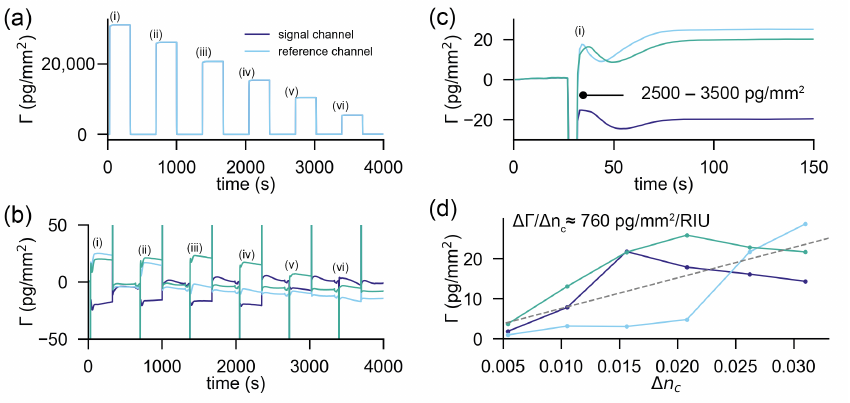
Figure 3. Response of a state-of-the-art Biacore 8k instrument to refractive index discontinuities: ( a ) signal and reference channel responses to the subsequent injections of six solutions with decreasing refractive index (i) 1.3640, (ii) 1.3592, (iii) 1.3528, (iv) 1.3486, (v) 1.3435 and (vi) 1.3384) into